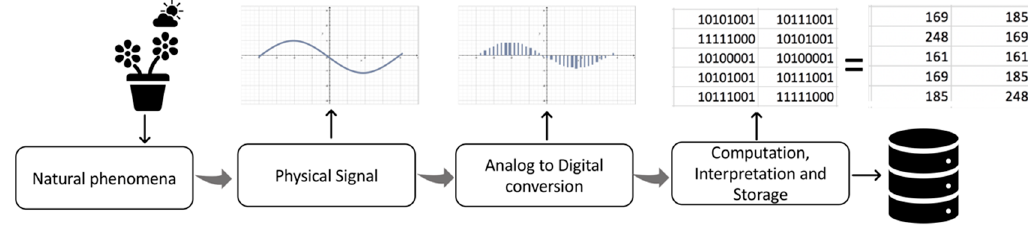
Figure 5 . An outline of data acquisition system. Figure 5. An outline of data acquisition